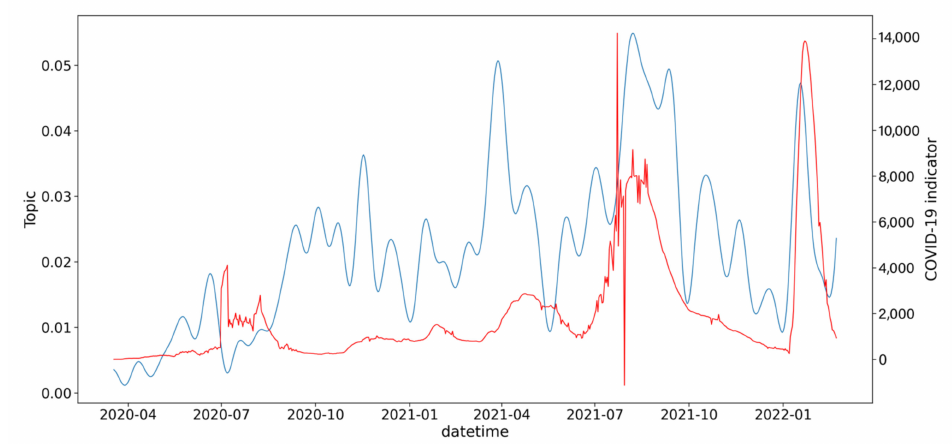
Figure A7. COVID-19 score—New cases. Topic—Incidence, School, Child, Growth, Epidemiological, Among, Week.